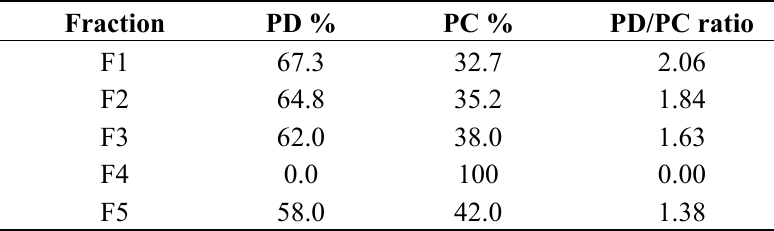
Table 3. PD to PC ratios of CT